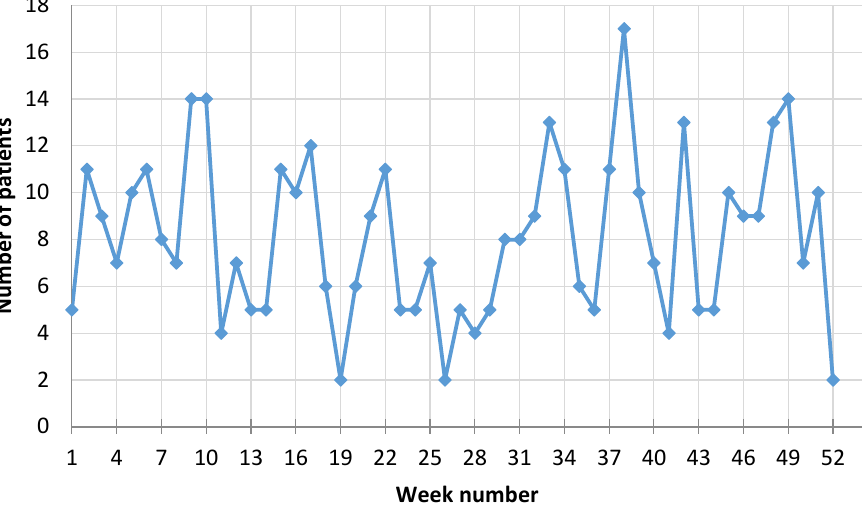
Figure 3. Number of men admitted with MI each week during 2016. Int. J. Environ. Res. Public Health 2018 , 15 , x